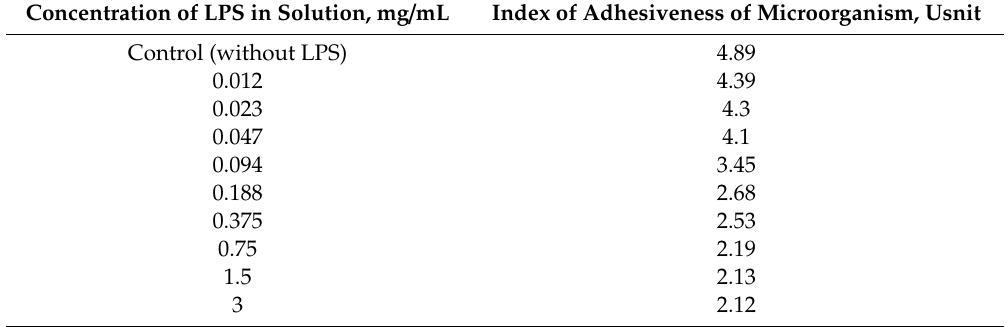
Table 5. E ff ect of di ff erent concentrations of P. agglomerans P324 LPS on the index of adhesiveness of E. coli .